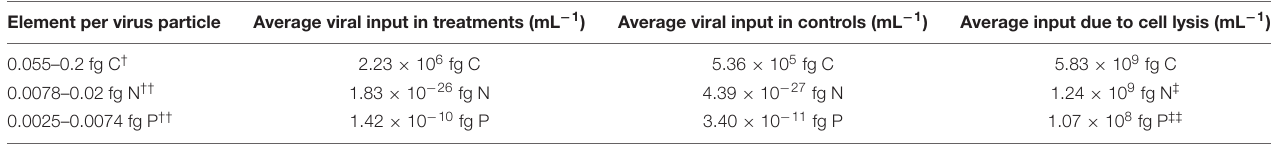
TABLE 2 | Average inputs of C, P, and N in the treatments and controls of the culture experiment by the virus particles, calculated with published estimates for the element ratios (N given for viruses with an average capsid size of 50–70 nm, which is comparable to the capsid size of the R. sulfidophilum phage). Element per virus